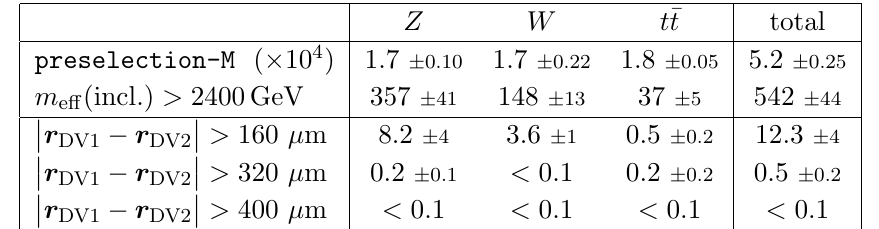
Table 7. The expected number of background (a) and signal (b) events for an integrated luminosity of L = 3000 fb (cid:0) 1 . We set the masses of gluino and the LSP to be 2800 GeV and 100 GeV, respectively.